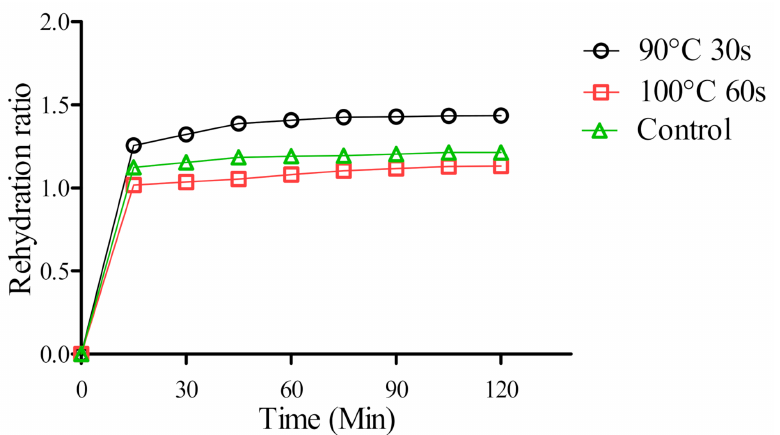
Figure 2. Rehydration behaviour of dried pomegranate arils at different blanching